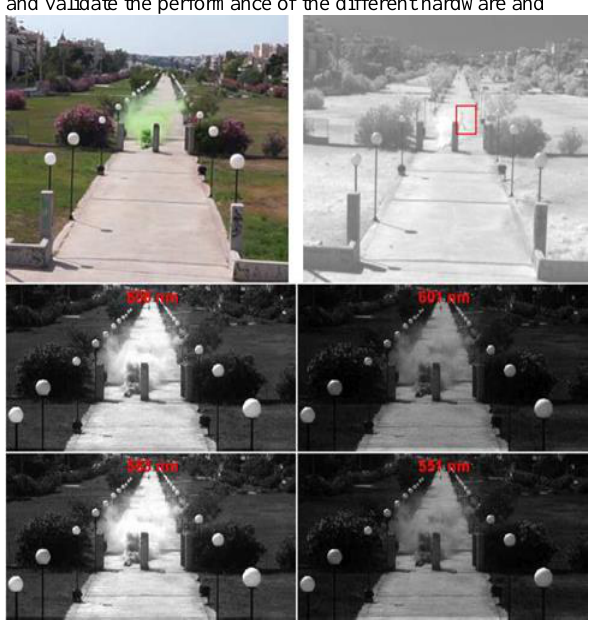
Figure 4: The multimodal data fusion module can detect the moving target even through smoke/fog conditions based on the best available modality, data association through temporal spectral signatures and efficient fusion modules on a given region of